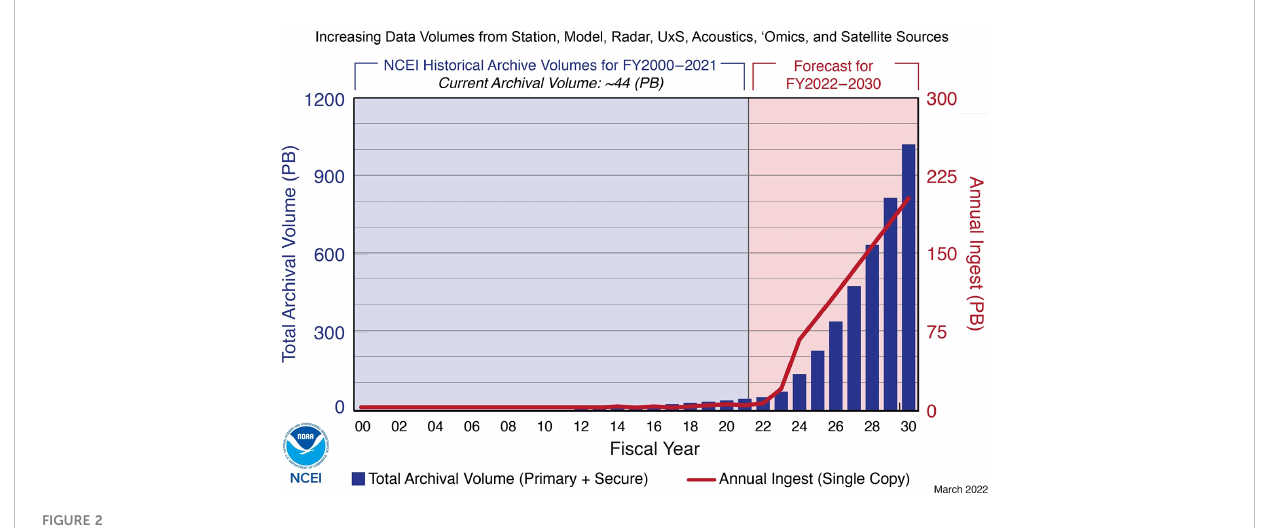
FIGURE 2 NCEI Archival Volume History and Forecast NCEI